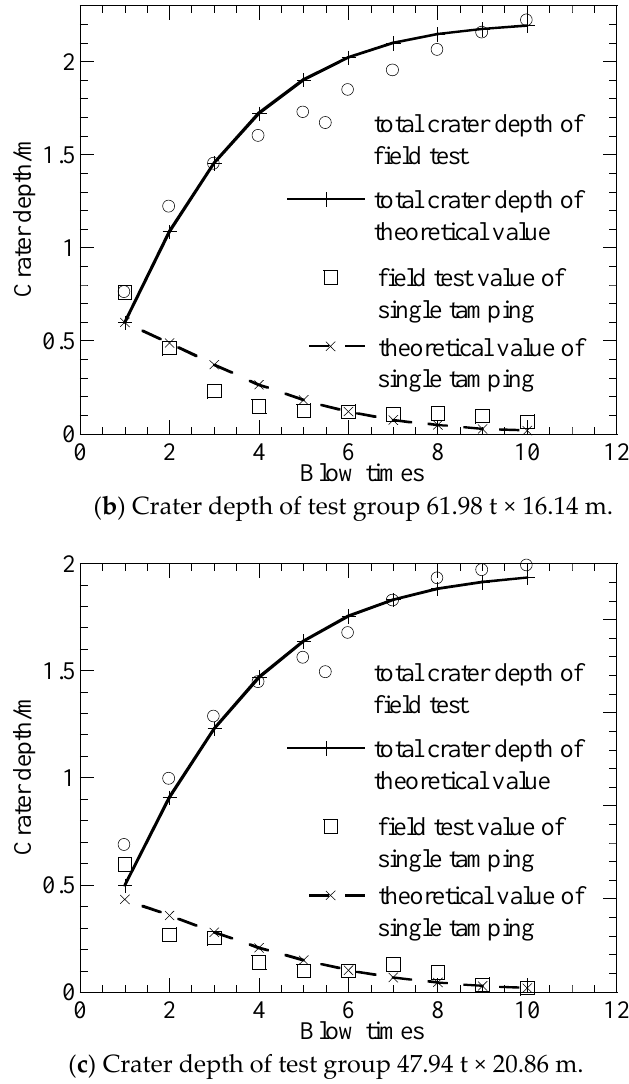
Figure 5. Crater depth obtained from the DC field test and theoretical results.